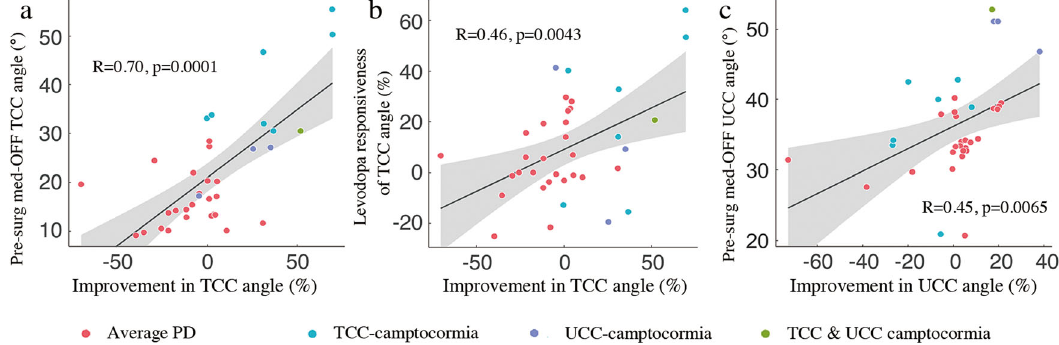
Fig. 3 Relation between improvement in camptocormia angles and clinical variables. The improvement in TCC angles was signi fi cantly correlated with pre-surgical values of TCC angles ( a ) and its responsiveness to levodopa ( b ); improvement in UCC angles was found correlated with pre-surgical UCC angles. Gray areas represent the 95% CI. PD: Parkinson ’ s disease; TCC: total camptocormia; UCC: upper camptocormia; pre-surg: pre-surgical.